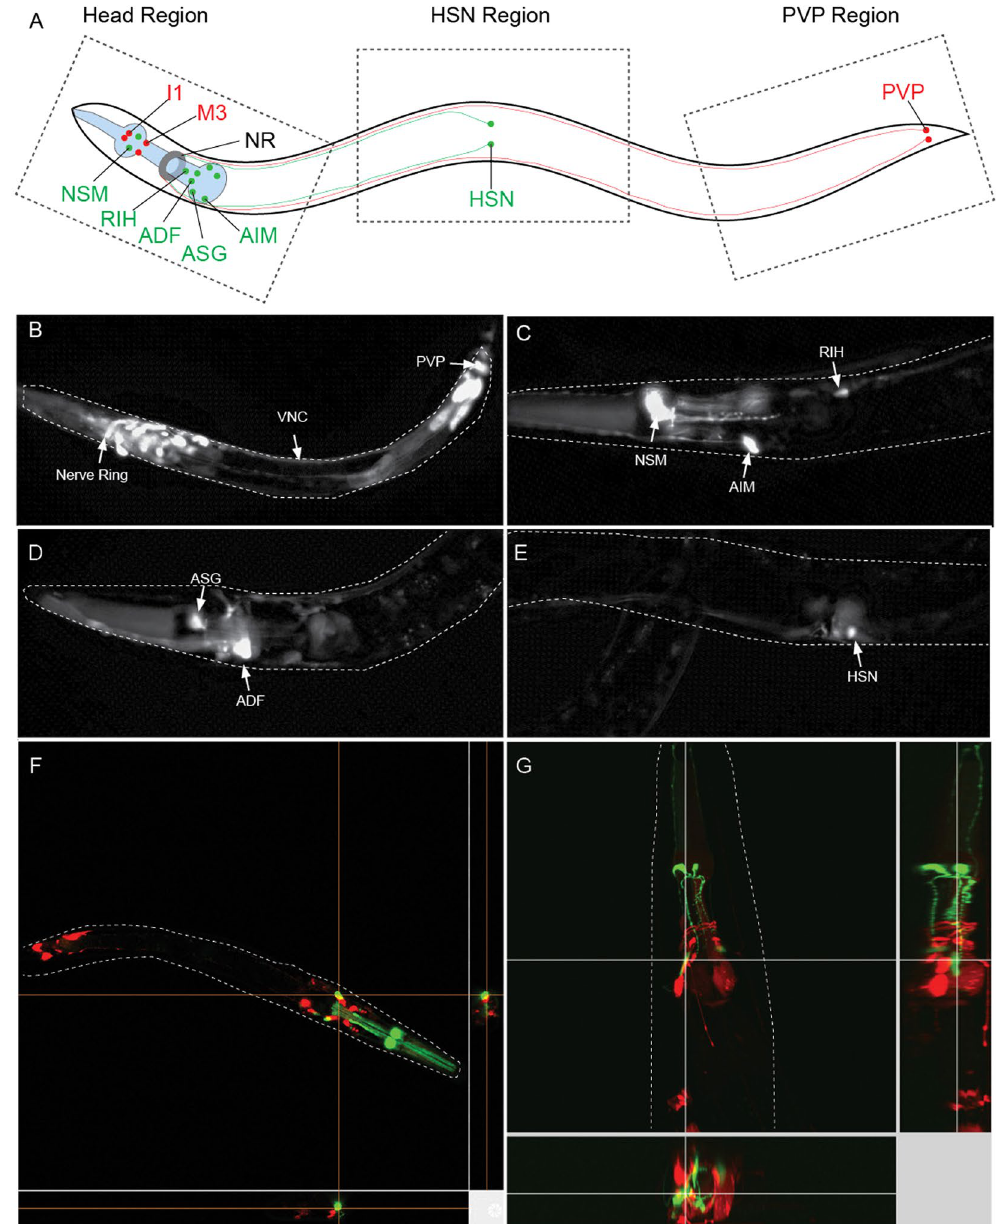
Figure 2. Expression from ddr-2 and tph-1 occurs in distinct populations of neurons. ( A ) Location of ddr-2 expressing neurons (red) and tph-1 expressing neurons (green), all neurons are bilaterally symmetrical apart from RIH. Neurons depicted with connections in the nerve ring (NR) are ADF, AIM, RIH, HSN and PVP. Not all ddr-2 expressing neurons with connections to the NR are depicted. ( B ) L4 worm expressing ddr-2::mCherry, expression is evident in neurons in the head region as well as PVP neurons and the ventral nerve cord (VNC). ( C–E ) Adult worms expressing tph-1::mCherry, expression is visible exclusively in serotonergic neurons. ( F–G ) Confocal images of L4 worm ( F ) and the head region of a 1 day old adult worm ( G ) expressing ddr-2::mCherry and tph-1::GFP. Orthogonal view of images confirms there is no co-expression of mCherry or GFP reporters in any neurons. See also supplementary video